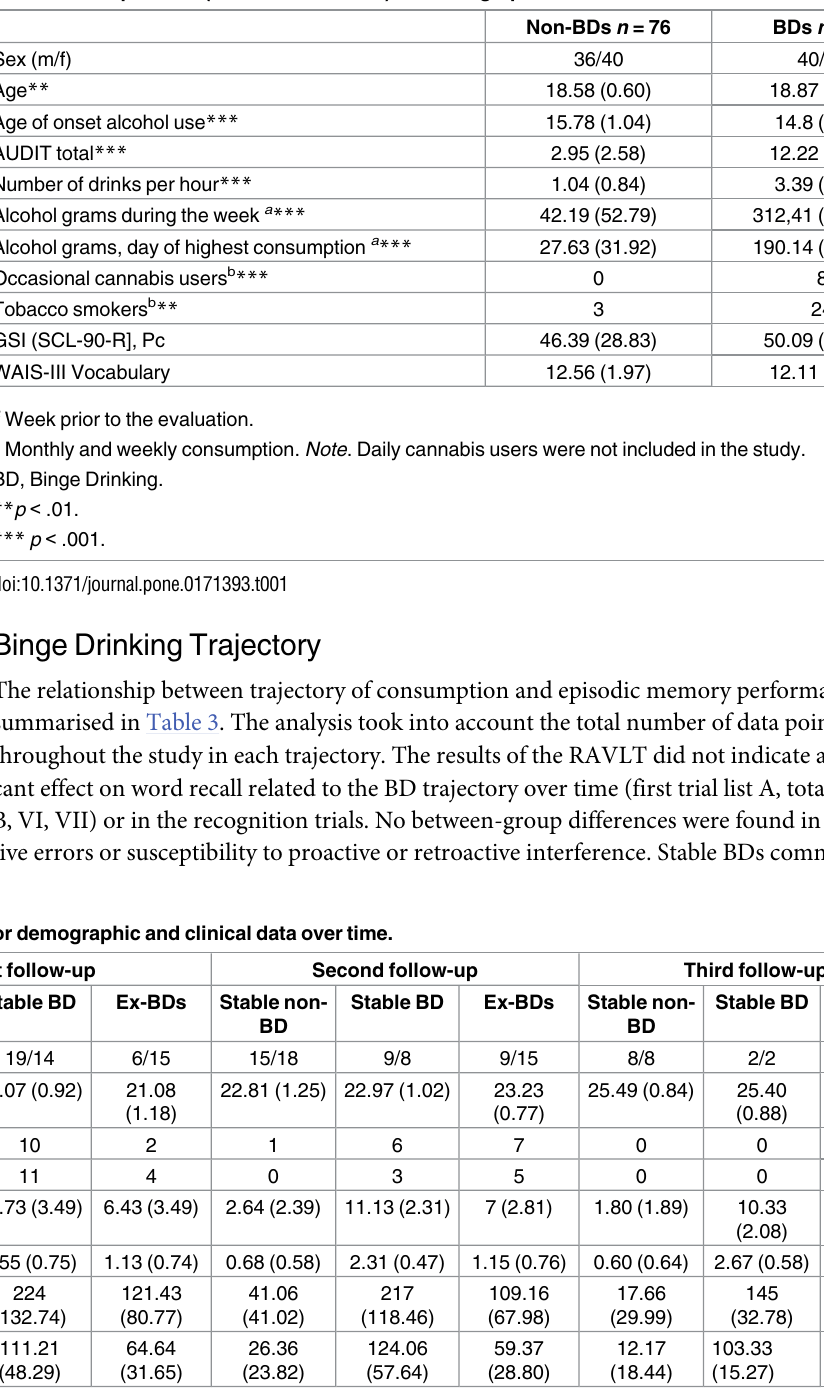
Table 1. Group means (standard deviation) for demographic and clinical data at baseline.